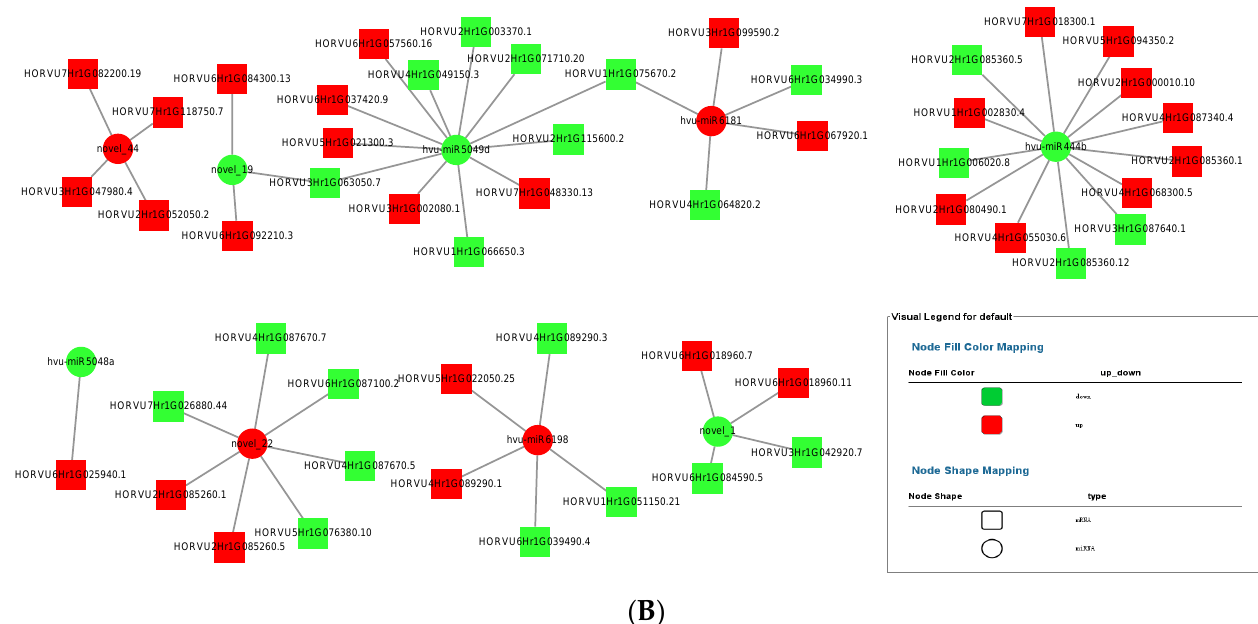
Figure 8. Networks of miRNA–mRNA. ( A ) Network of miRNA–mRNA for 3 dai vs. mock. miRNA– mRNA network was constructed for 3 dai vs. mock based on the co-expression correlation of miRNA–mRNA (Circle node: miRNA. Diamond nodes: mRNA. Red color: up-regulation; green color: down-regulation). ( B ) Network of miRNA-mRNA for 7 dai vs. mock. miRNA–mRNA network was constructed for 7 dai vs. mock based on the co-expression correlation of miRNA-mRNA (Circle node: miRNA. Diamond nodes: mRNA. Red color: up-regulation; green color: